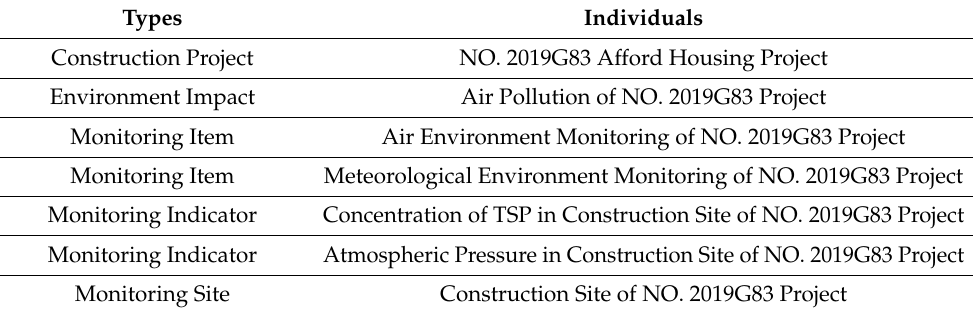
Table 5. Individuals database in the ontology